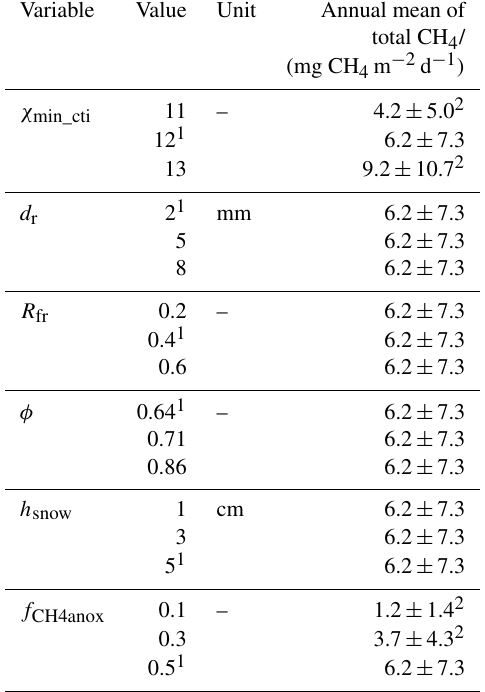
Table 2. Results from sensitivity experiments (the specific descrip- tions of the parameters listed below are given in Table 1). Statistical p -values are given for the experiments whose results significantly differ from the results in the reference